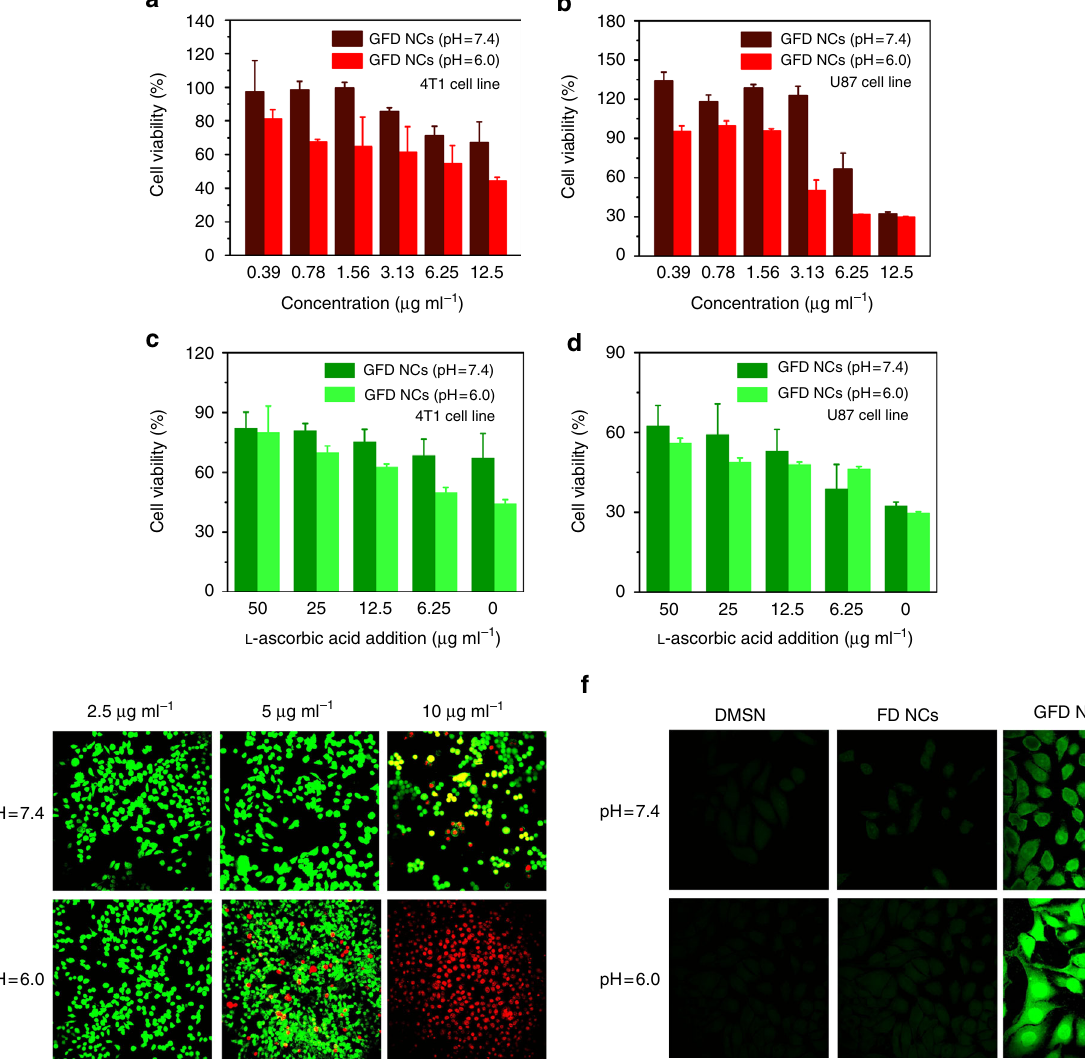
Fig. 4 In vitro cytotoxicity pro fi les and intracellular catalytic mechanism. In vitro 4T1 ( a ) and U87 ( b ) cytotoxicity pro fi les of GFD NCs under neutral (pH = 7.4) and acidic (pH = 6.0) conditions. L -ascorbic acid-assisted cell rescue pro fi les of ( c ) 4T1 and ( d ) U87 cancer cells ’ cytotoxicity induced by 12.5 μ g ml − 1 of GFD NCs. Mean values and error bars are de fi ned as mean and s.d., respectively. Experiments were performed in quadruplicate. e CLSM images of viable and dead cell distributions after co-incubation with GFD NCs at varied concentrations: 2.5, 5, and 10 μ g ml − 1 under neutral (pH = 7.4) and acidic (pH = 6.0) conditions for 4 h and subsequently stained with calcein-AM/PI solutions. f CLSM images of 4T1 cells after co-incubation with DMSN, FD NCs, and GFD NCs under neutral (pH = 7.4) and acidic (pH = 6.0) conditions for 4 h and subsequently stained with ROS fl uorescence probe average hydrodynamic diameters ( D h ) of DMSN, FD NCs, and GFD NCs are respectively at around 237.6, 319.6, and 255.3 nm (Supplementary Fig. 4c), and the zeta potentials are elevated from − 45.6 to − 32.0 mV and − 27.6 mV, correspondingly (Supplemen- tary Fig. 4d). Thermogravimetric (TG) and inductively coupled plasma-optical emission spectrometry (ICP-OES) measurements were used to determine the loading amounts of the GOD and Fe 3 O 4 NPs in GFD NCs, which are 16.61% as calculated from TG curve of FD NCs and GFD NCs, and 15.87% as determined by ICP-OES of GFD NCs, respectively.